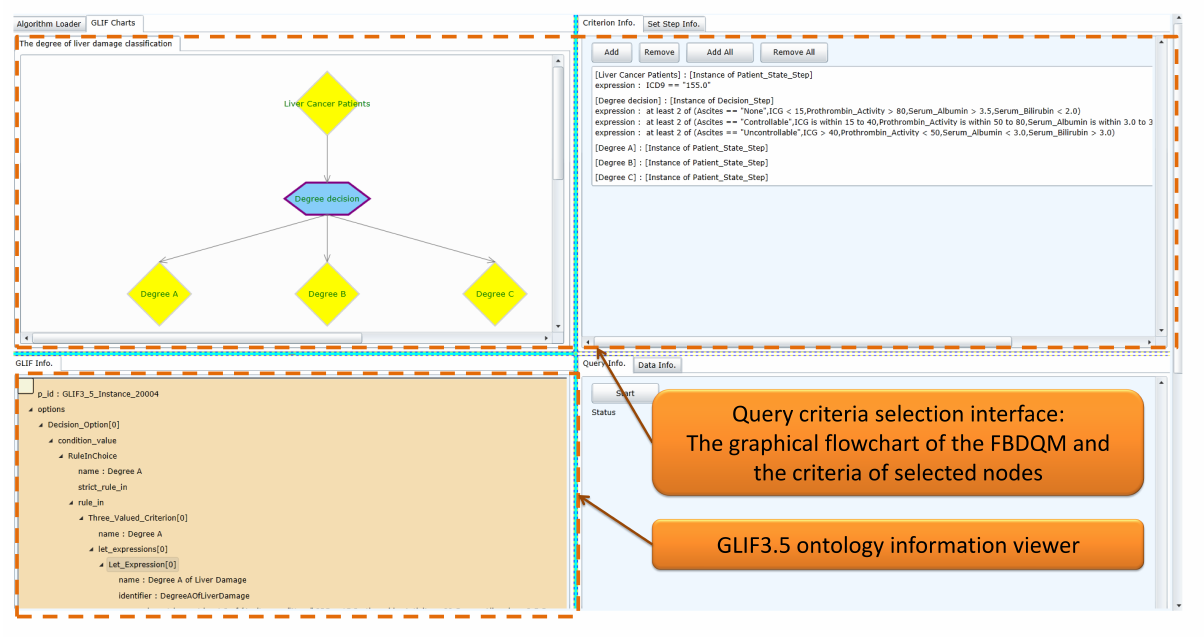
Figure 4. The query criteria selection interface and the GLIF3.5 ontology information